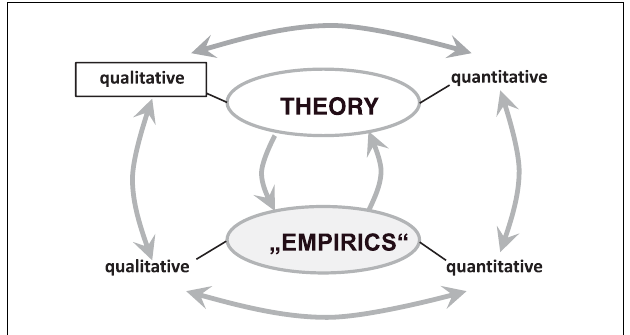
FIGURE 1 | Interplay in research between theory and “empirics” and from a qualitative level to a quantitative (formalized) level of essential constructs, with focus on qualitative theory of the